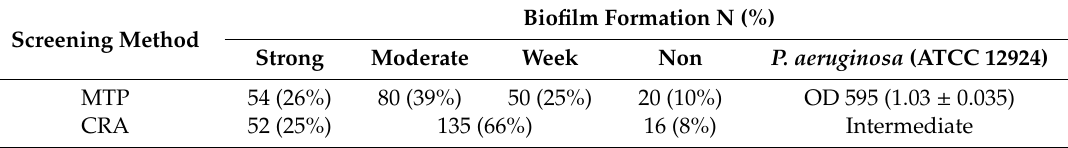
Table 2. Screening of 204 isolates for biofilm formation by MTP and CRA methods. Screening